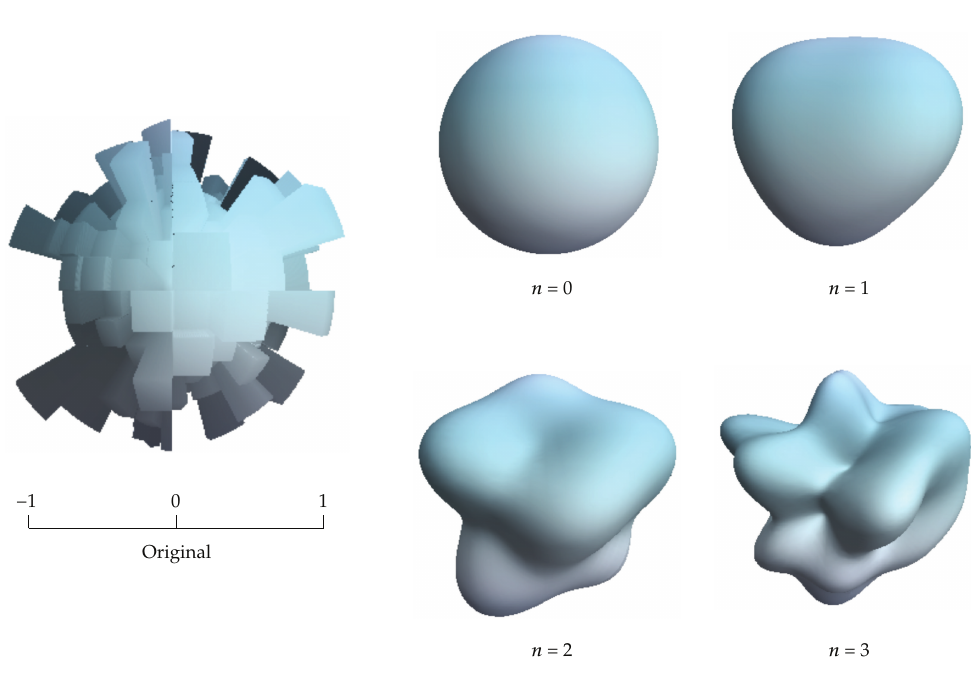
Figure 4: Original scalar-valued ODF sampling from N (cid:3) 1 . 0 , 0 . 3 2 (cid:4) and its approximate ODFs using asym- metric characterization in